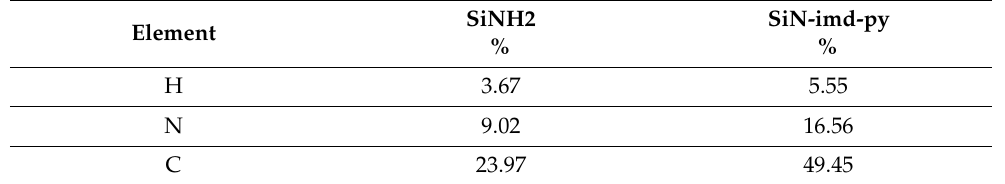
Table 1. Elemental analysis of SiN-imd-py and SiNH2. Element